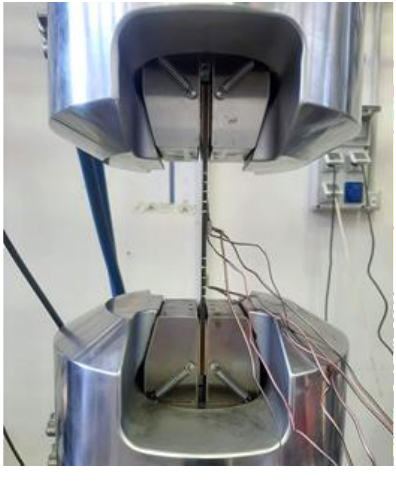
Figure 7. Test rig. Figure 7. Test rig.